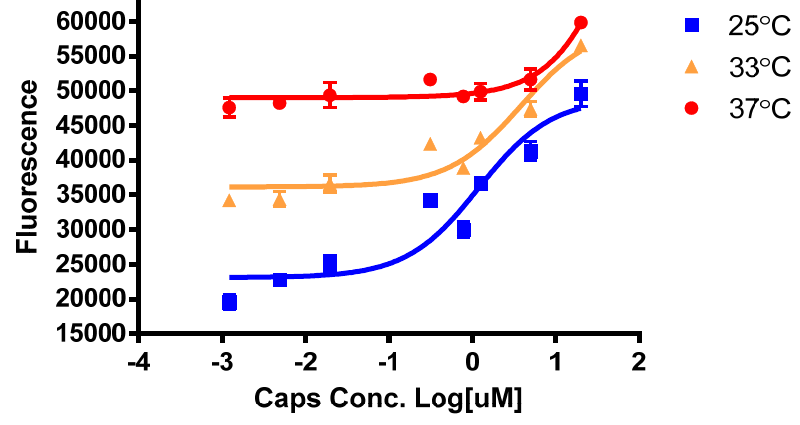
Figure 2. TRPV1 cells pre-incubated at 25 °C for 30 min, prior to addition of agonist, gives better